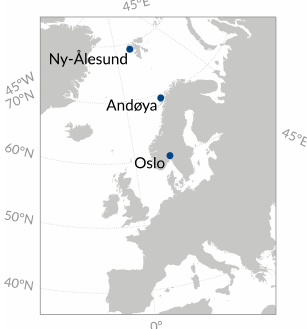
Figure 1. Map of Europe showing the three measurement stations used in this